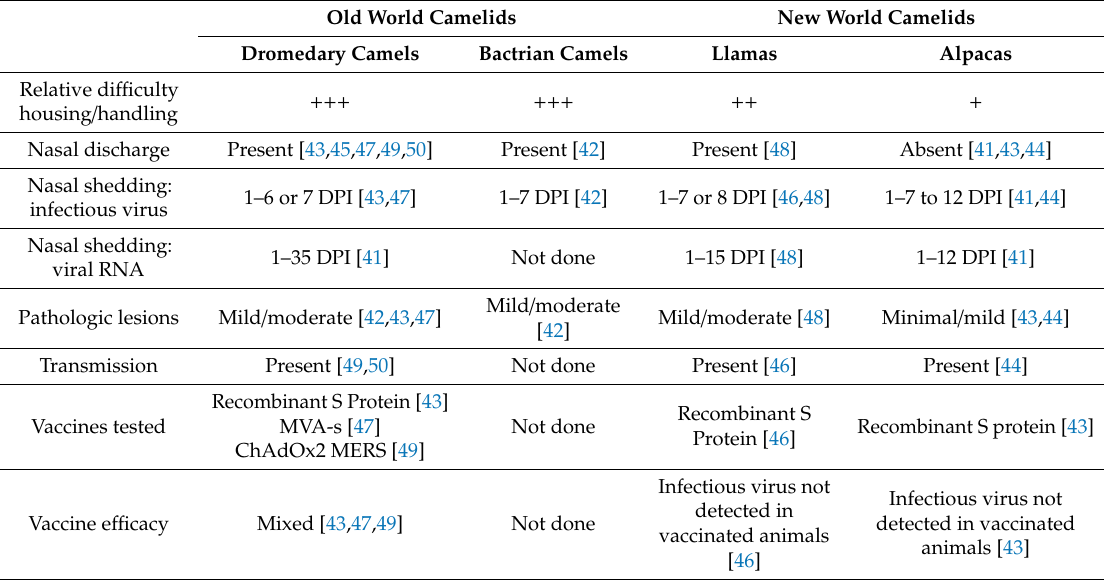
Table 1. Camelid Models of